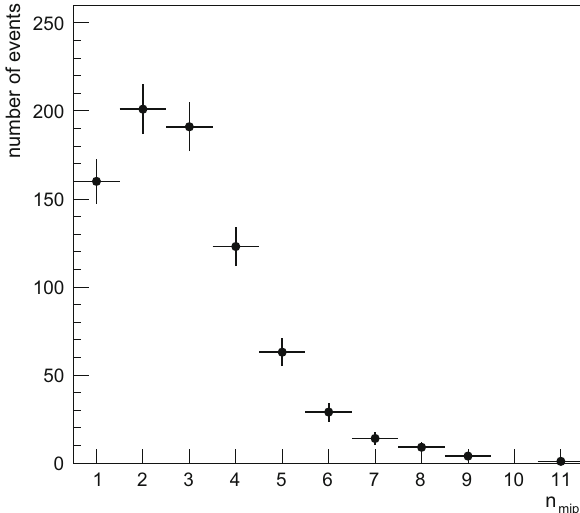
Fig. 5 Multiplicity distribution of backward and forward black tracks Table 1 The numbers of hadron ( n ch ) and muon ( n μ ) tracks per event as a function of the emission angle